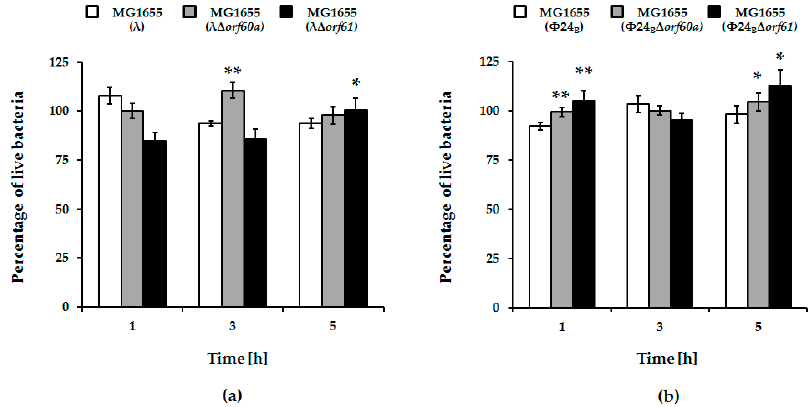
Figure 3. Percentage of live E. coli MG1655 cells lysogenic with λ (panel ( a )) and Φ 24 B (panel ( b )), either wild-type (white columns), Δ orf60a (grey columns), or Δ orf61 ( black columns) during prophages induction with 1 mM hydrogen peroxide. The presented results are mean values from three biological experiments with error bars indicating S.D. Statistical analysis was performed by using Student's t -test. Significant differences between fractions of bacterial cells lysogenic with wild-type phages and their deletion mutants are marked by asterisks, p < 0.05 (*) or p < 0.01 (**).